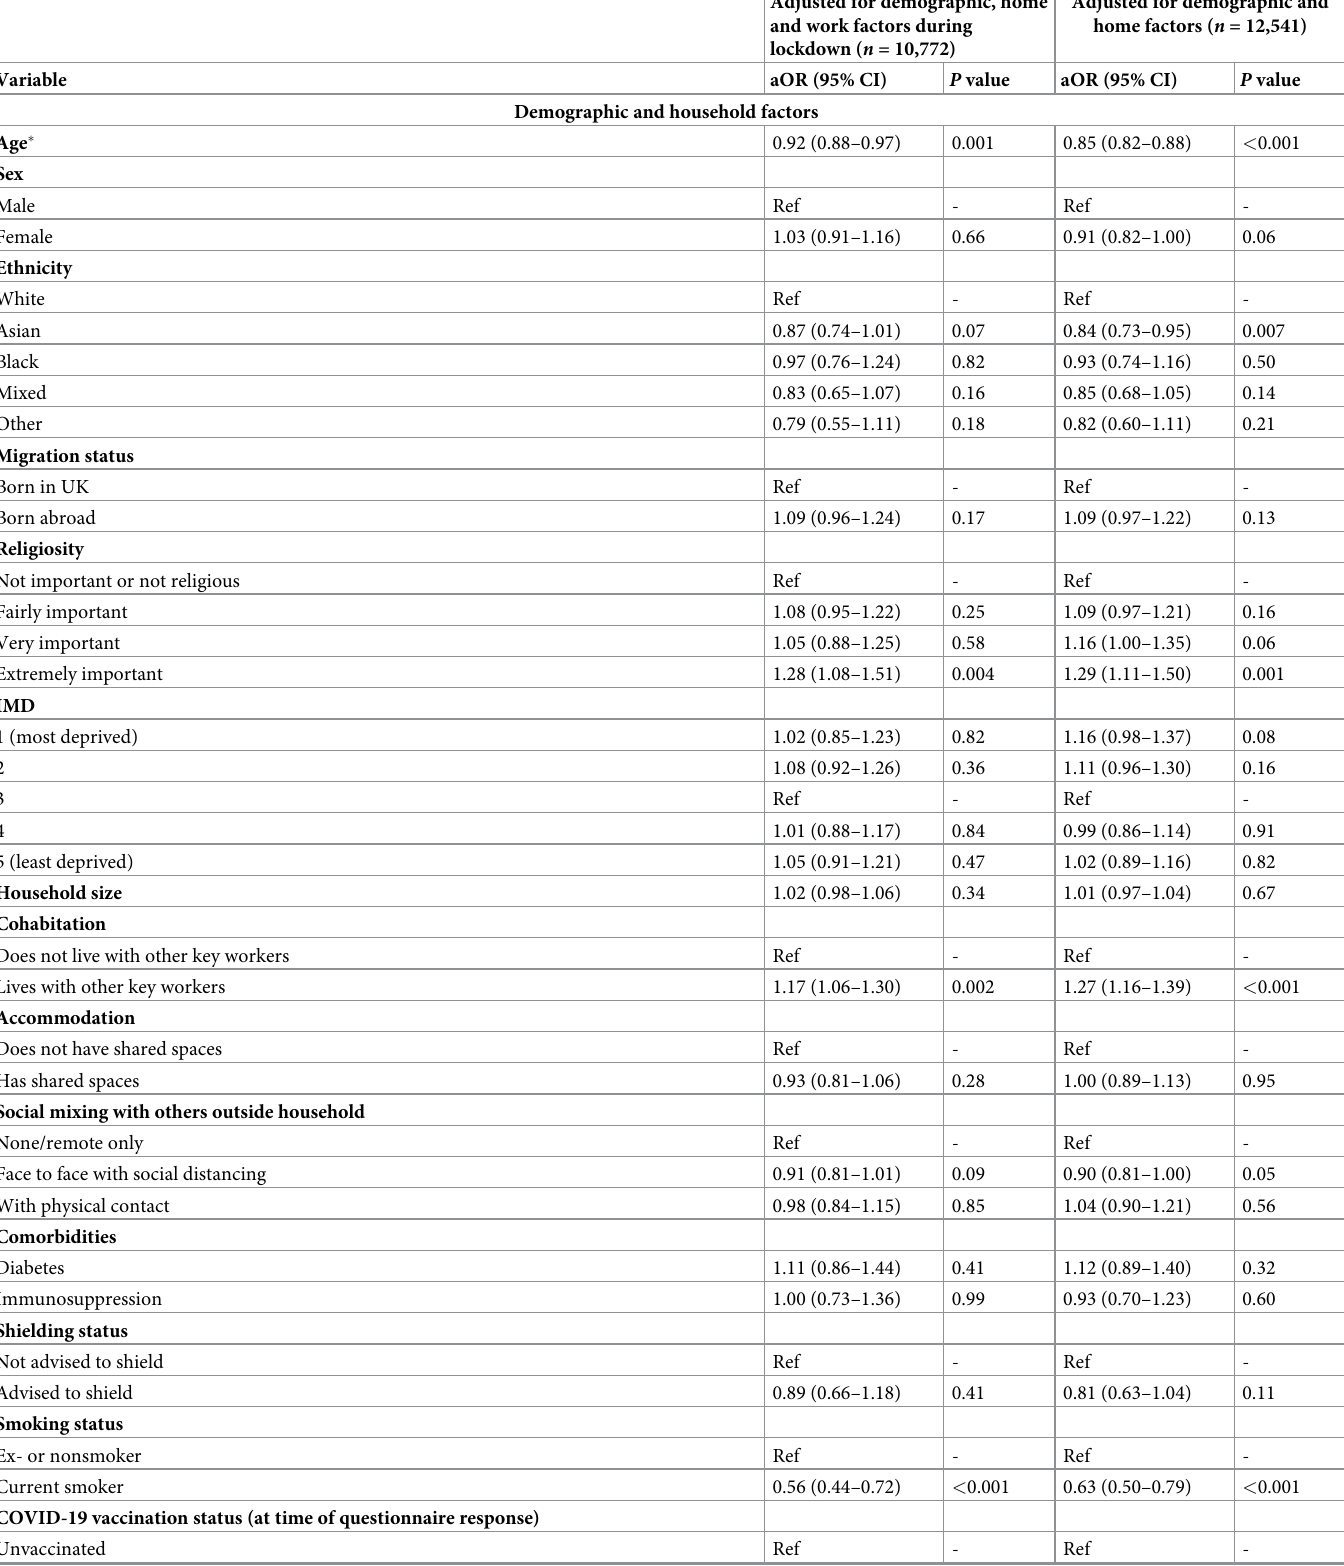
Table 3. Multivariable analysis of factors associated with SARS-CoV-2 infection.